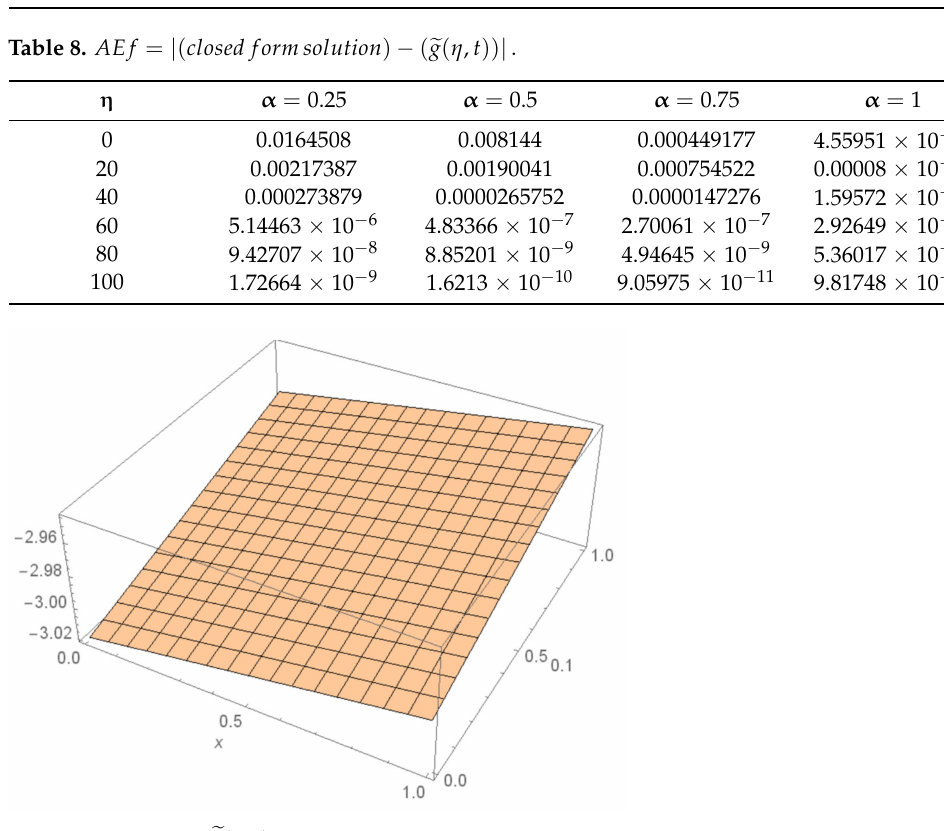
(cid:16) (cid:101) f ( η , t )